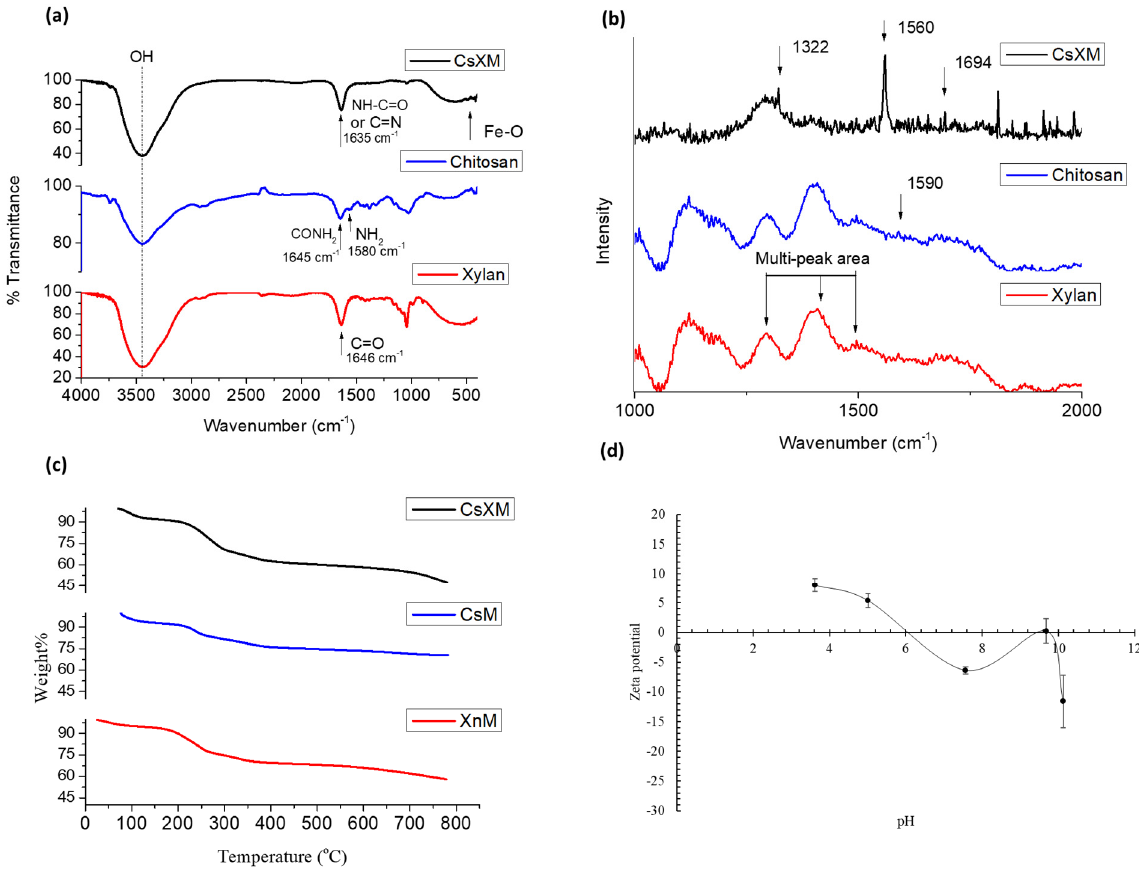
Figure 1. ( a ) FTIR spectra of CsXM, chitosan and xylan, ( b ) Raman spectra for CsXM, chitosan, and xylan, ( c ) TGA profiles for CsXM, CsM, and XnM, and ( d ) zeta potential of CsXM at different pHs.